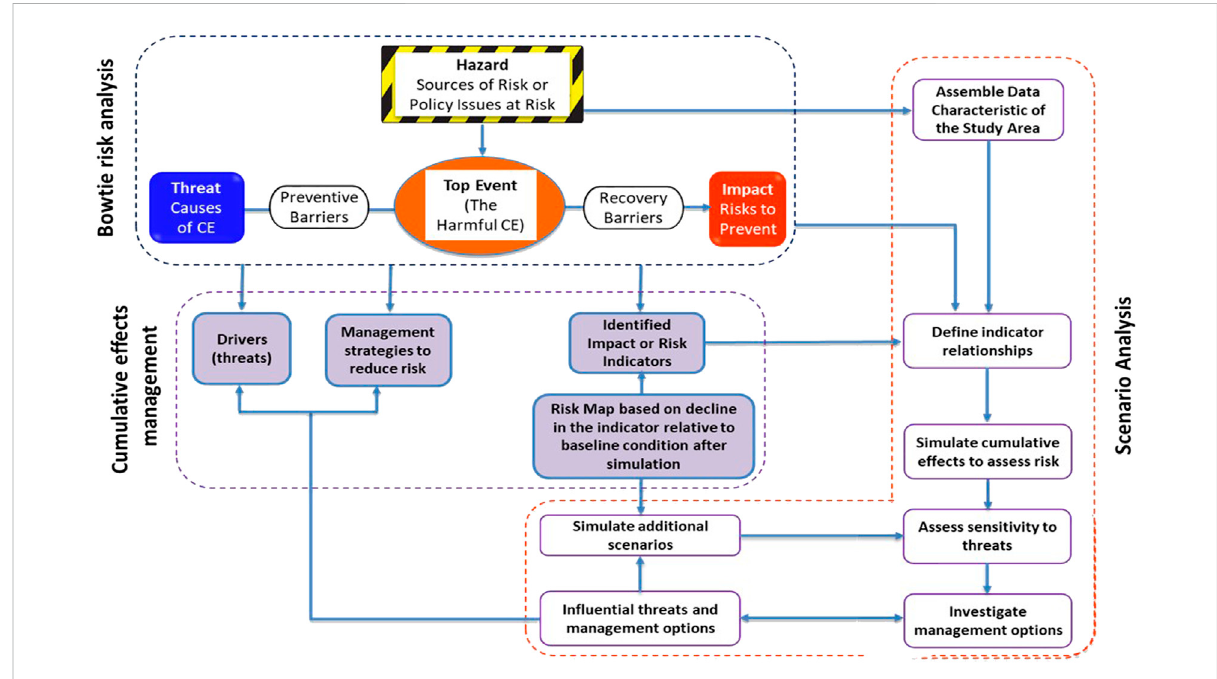
FIGURE 2 Integrated risk and scenario based analysis for regional cumulative effects